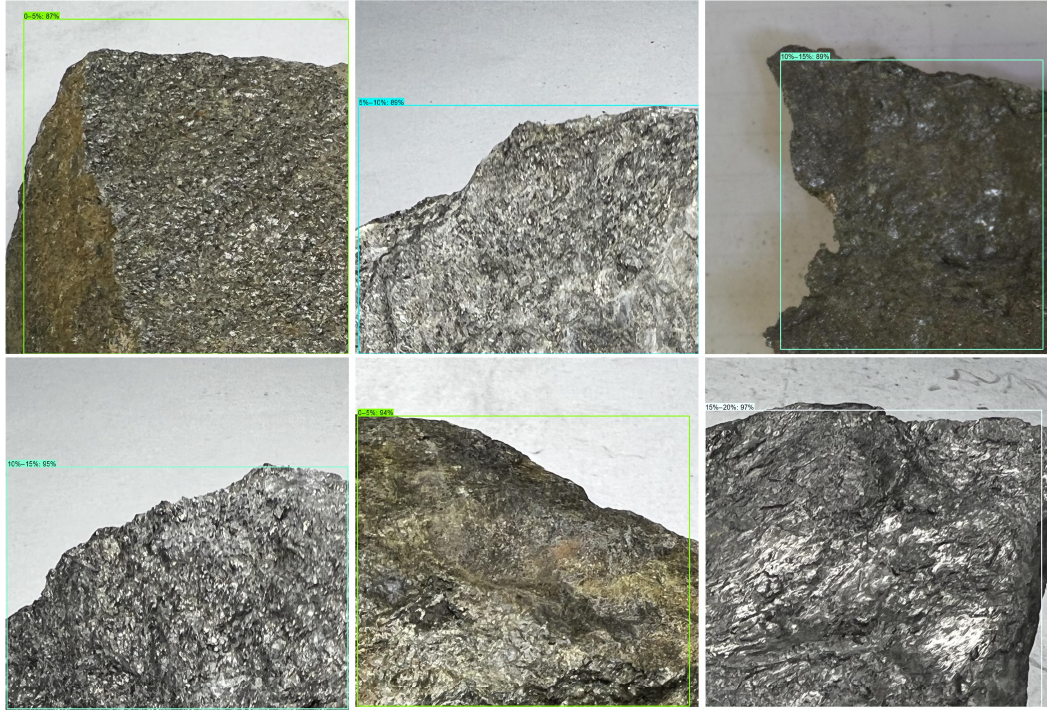
Figure 16. Recognition e ff ect diagram .